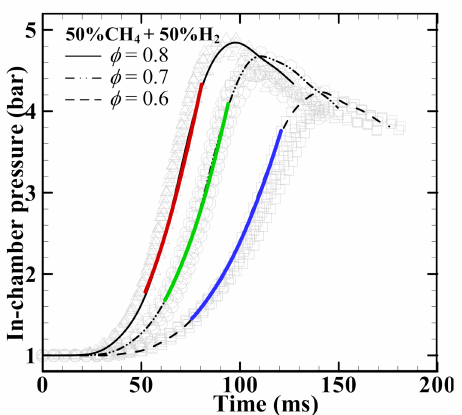
Figure 3. In-chamber pressure profiles (thin curves) and their fitting curves (bold-solid curves).